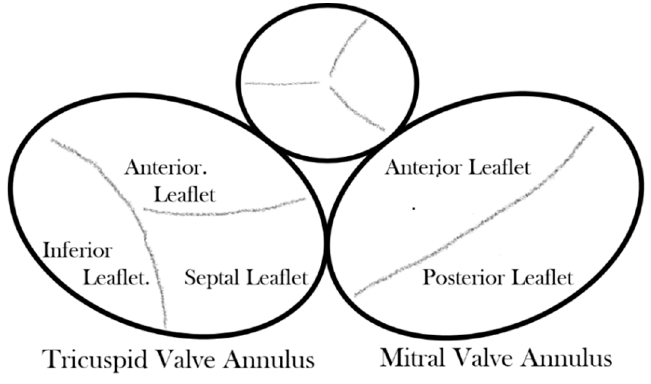
Figure 2. Drawing of the normal atrioventricular junction.